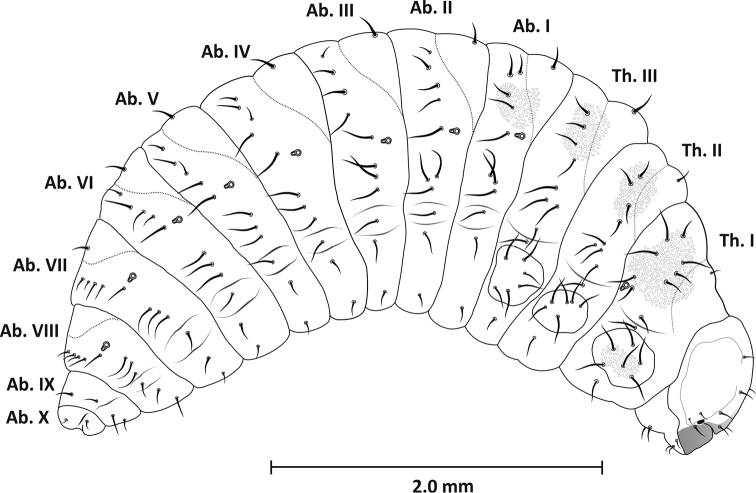
Mature larva (L3), lateral view.